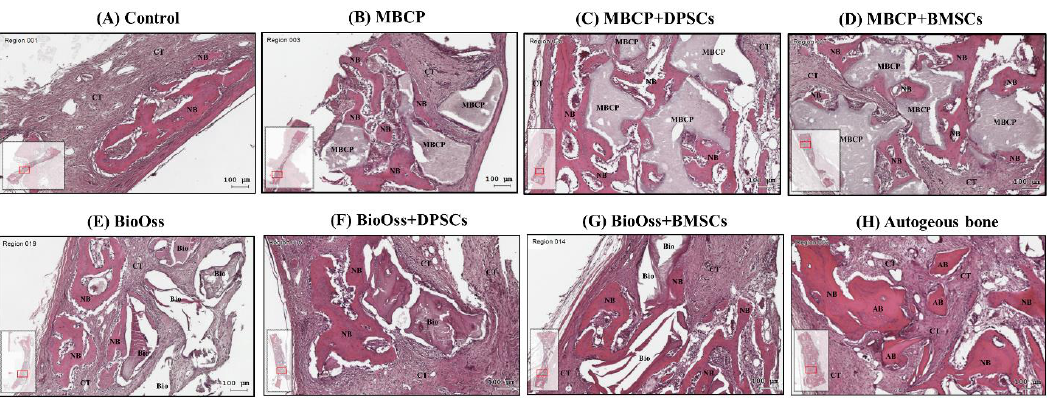
Figure 6. Histological analysis of calvarial bone defects after 2 weeks of healing in ( A ) the empty control, ( B ) MBCP, ( C ) MBCP+DPSCs, ( D ) MBCP+BMSCs, ( E ) Bio-Oss, ( F ) Bio-Oss+DPSCs, ( G ) Bio-Oss+BMSCs, and ( H ) autogenous bone groups. NB = new bone, CT = connective tissue, MBCP = MBCP, Bio = Bio-Oss, and AB = autogenous bone. Scale bar = 100 μm.